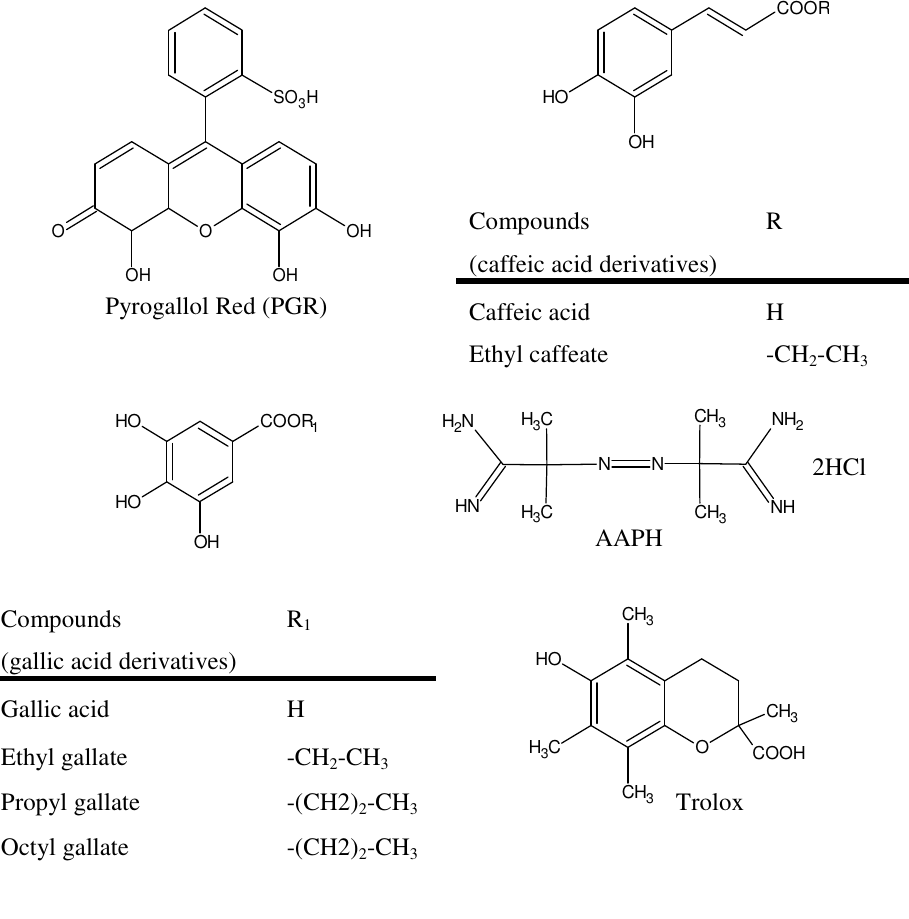
Figure 8. Chemical structure of pyrogallol red (PGR), Trolox, AAPH, caffeic and gallic acid